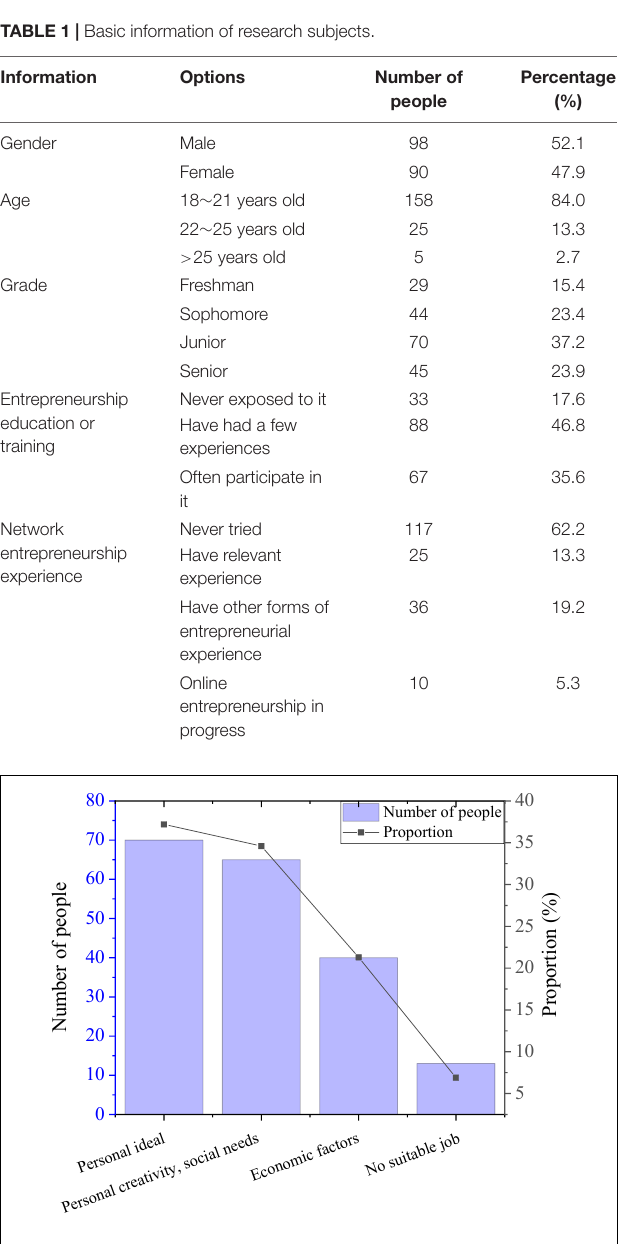
FIGURE 4 | Entrepreneurship motivation survey results.